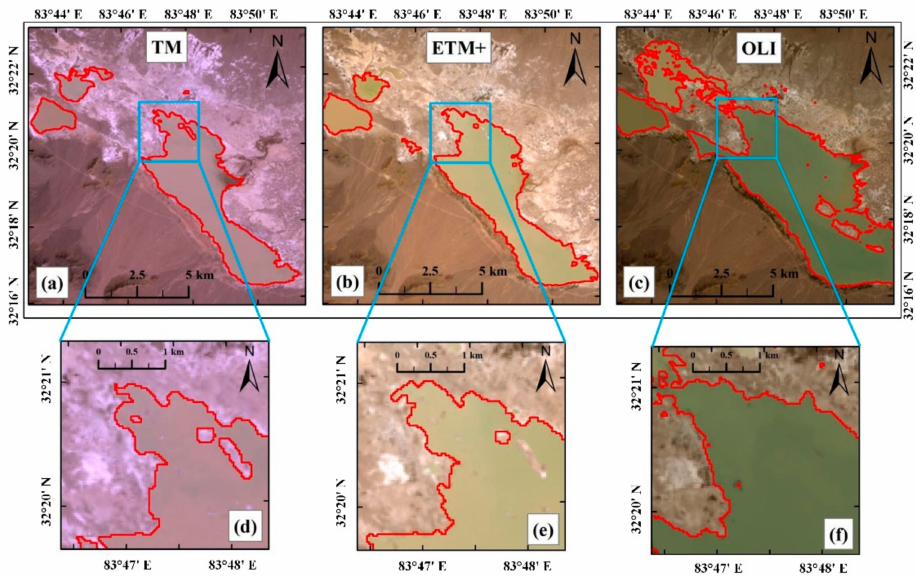
Figure 5. Lake extraction results based on Landsat TM, ETM+, and OLI: ( a , d ) Lake extraction results based on Landsat TM, ( b , e ) Lake extraction results based on Landsat ETM+, ( c , f ) Lake extraction results based on Landsat